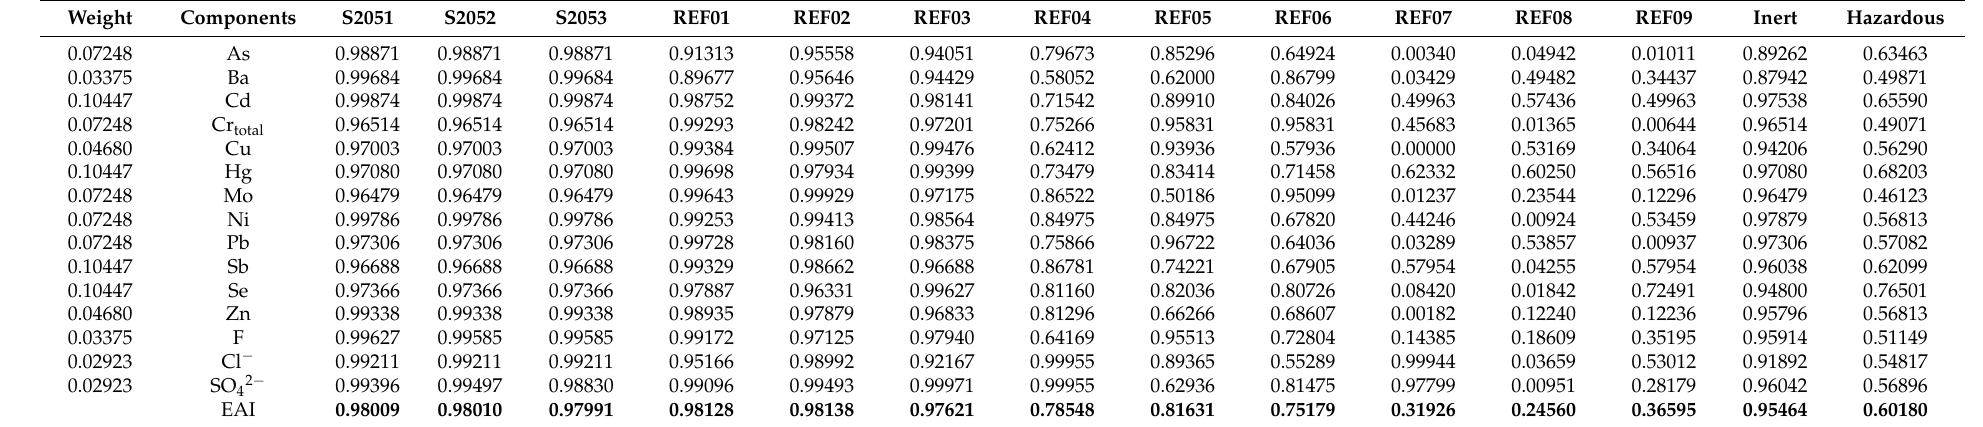
Table 6. Results of the EAI for the studied refractory samples and inert